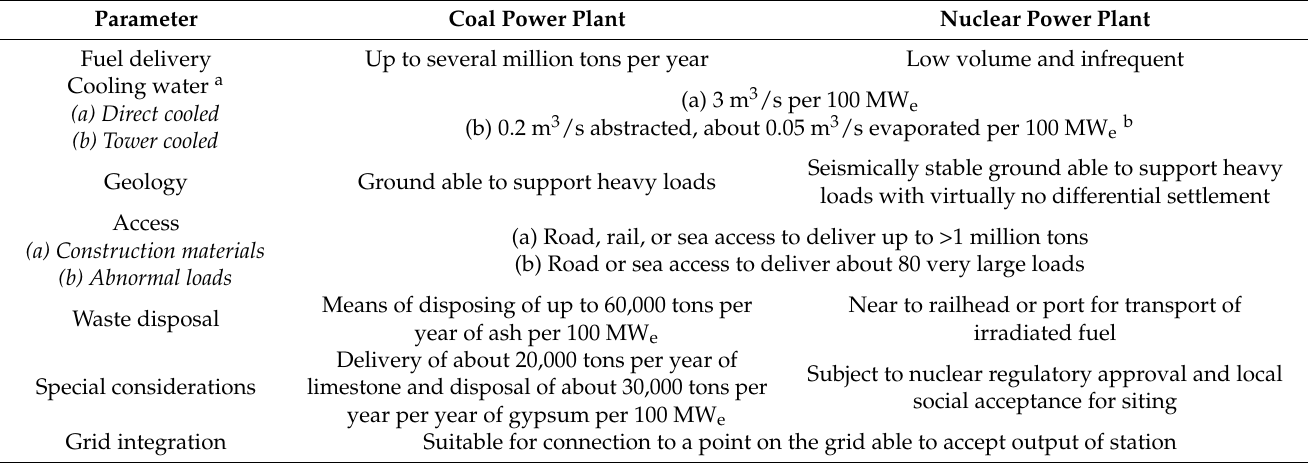
Table 8. Technical Site Requirements Comparison, Coal and